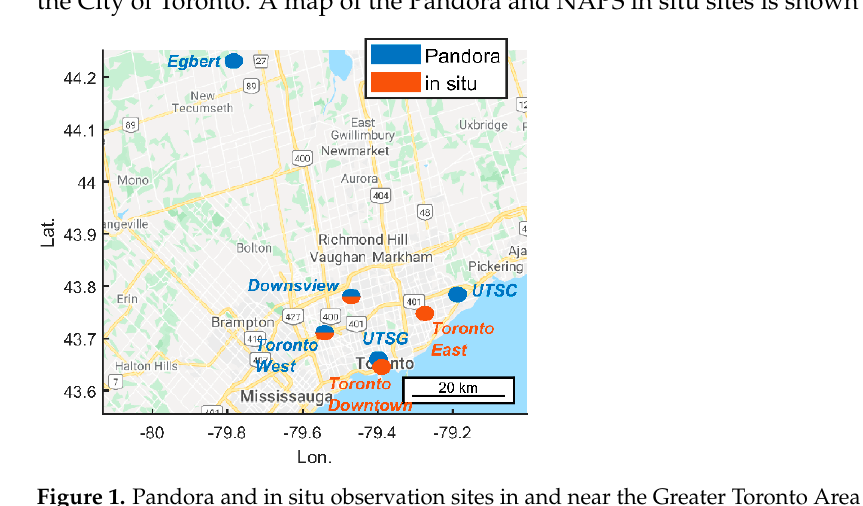
Figure 1. Pandora and in situ observation sites in and near the Greater Toronto Area (base map from © Google Maps). © Google